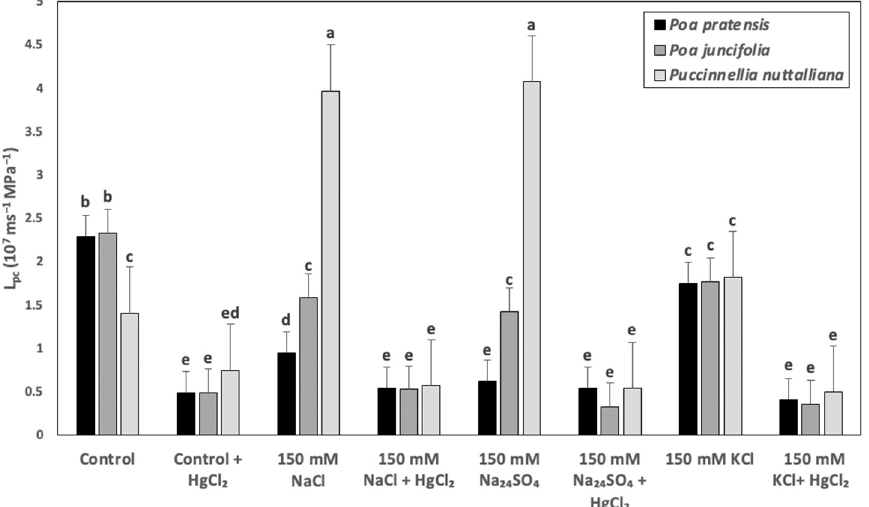
Figure 5. Cell hydraulic conductivity (L pc ) of root cortex cells in Poa pratensis , Poa juncifolia , and Puccinellia nuttalliana plants treated with 150 mM NaCl, 150 mM Na 2 SO 4 , and 150 mM KCl for 6 days and in untreated control. The roots were exposed to their respective salt treatments in 50% Hoagland’s solutions (no salt for controls) followed by 50 µ M HgCl 2 . Means ( n = 6) and SE are shown. Different letters above the bars indicate significant differences ( p ≤ 0.05) between treatments and species as determined by the Tukey’s test.